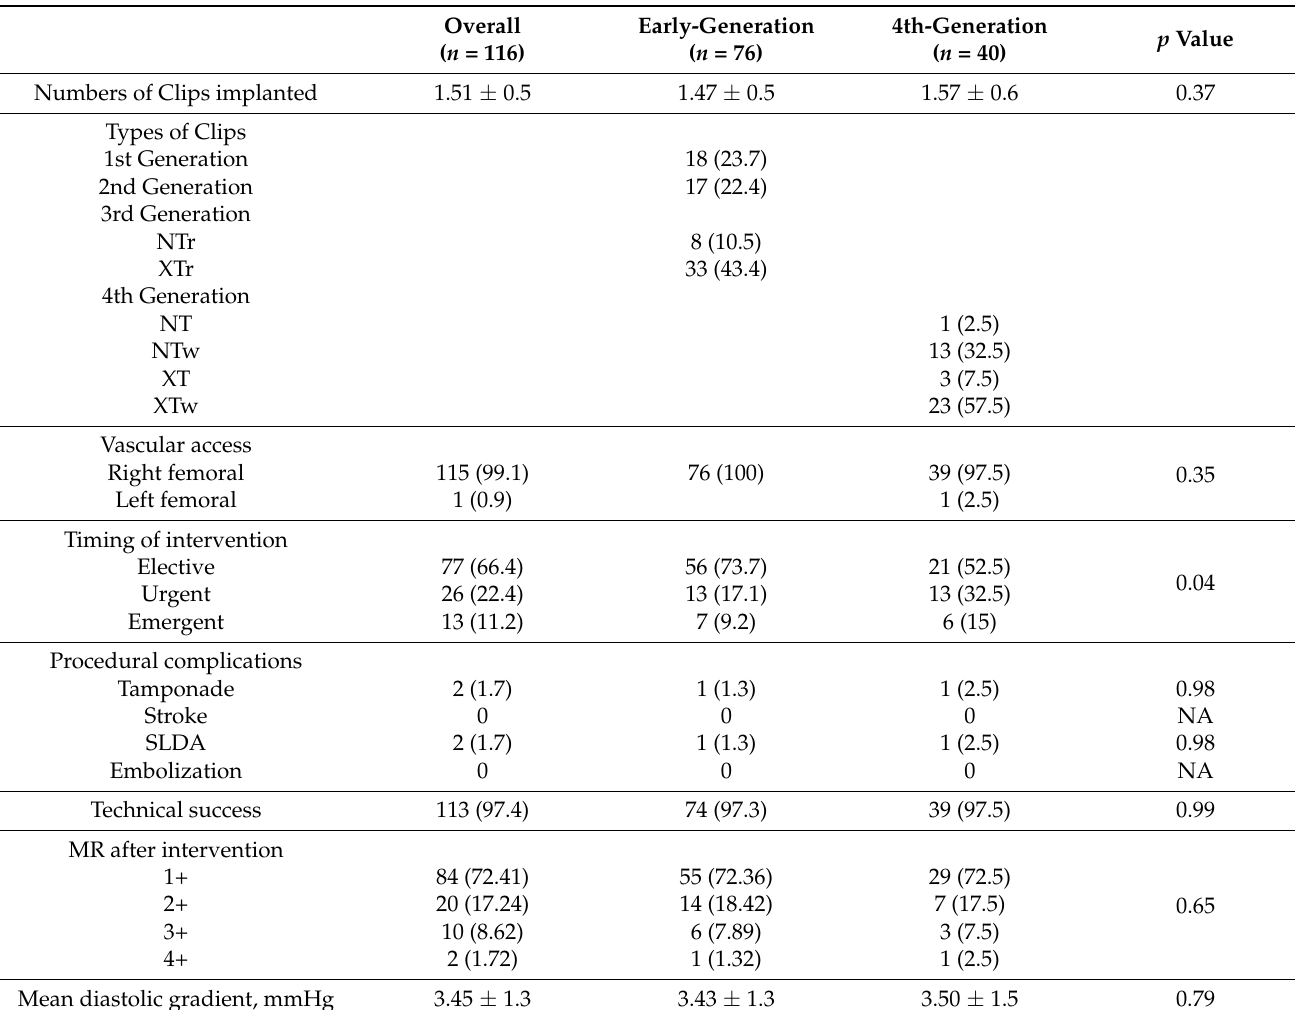
Table 3. Procedural features for the whole cohort and according to the device generation used.